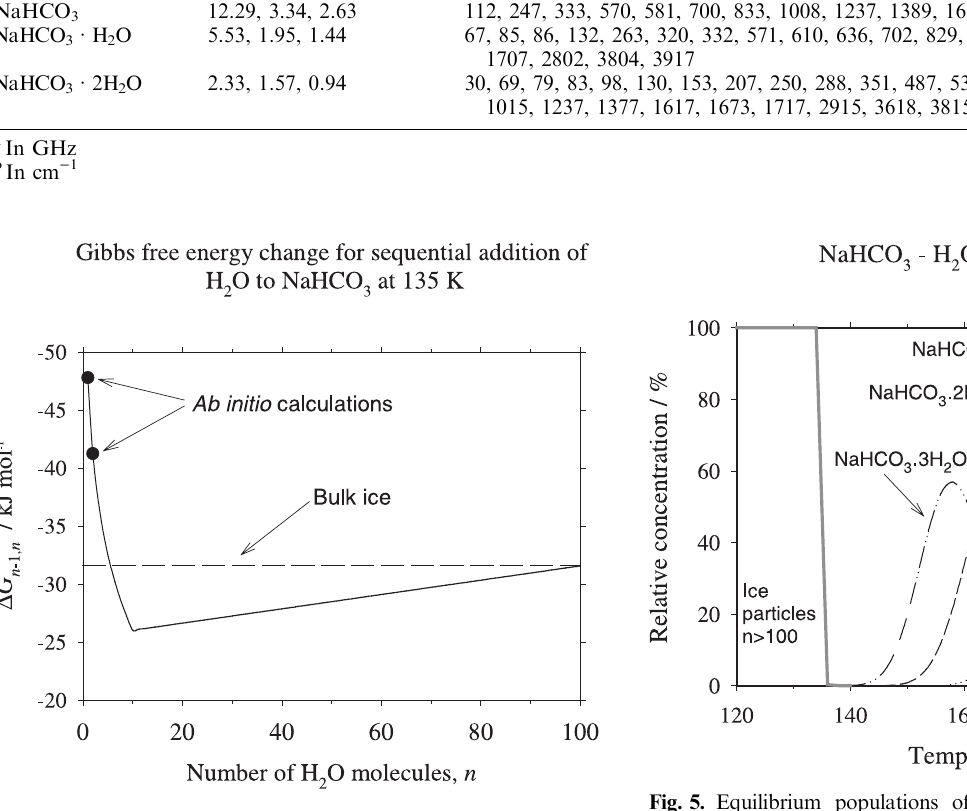
, the Gibbs free energy for n ) 1, n O to a NaHCO (H O) cluster, as a 2 3 2 n ) 1 and D G are derived from the present 0,1 1,2